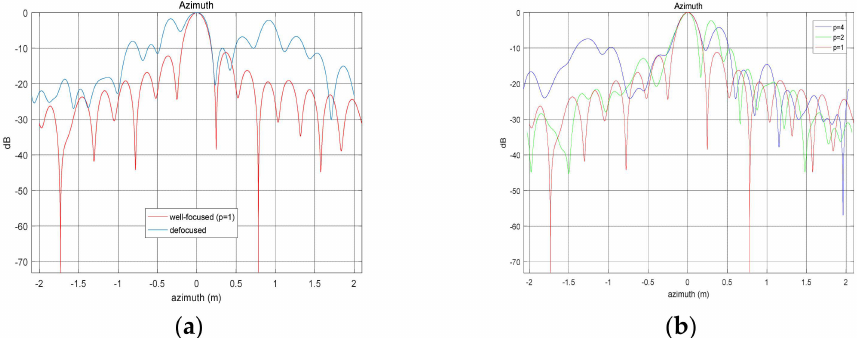
Figure 15. ( a ) Focusing quality comparison between performing motion compensation ( p = 1) and not performing motion compensation in the azimuth direction; ( b ) Focusing quality comparison when p = 1, 2, 4 in the azimuth